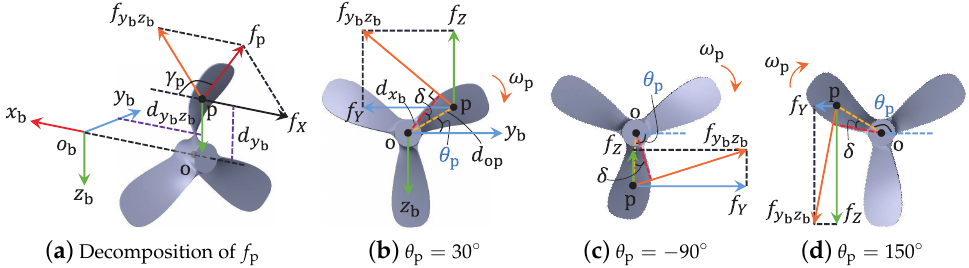
Figure 2. Periodically additive forces on the deformed blade, where ( a ) gives the decomposition of the additive resultant force f p , meanwhile, ( b – d ) present the force decompositions at the rotation angles of θ p = 30 ◦ , θ p = − 90 ◦ , and θ p = 150 ◦ ,